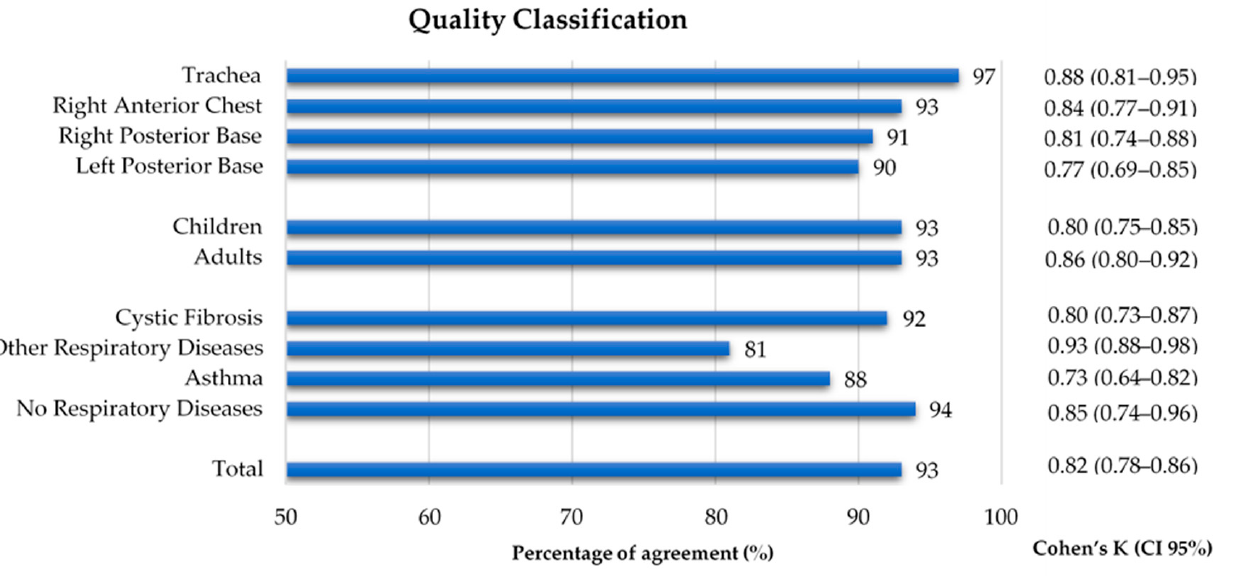
Table 2. Proportion of sounds with quality by location, age group and diagnostic group.